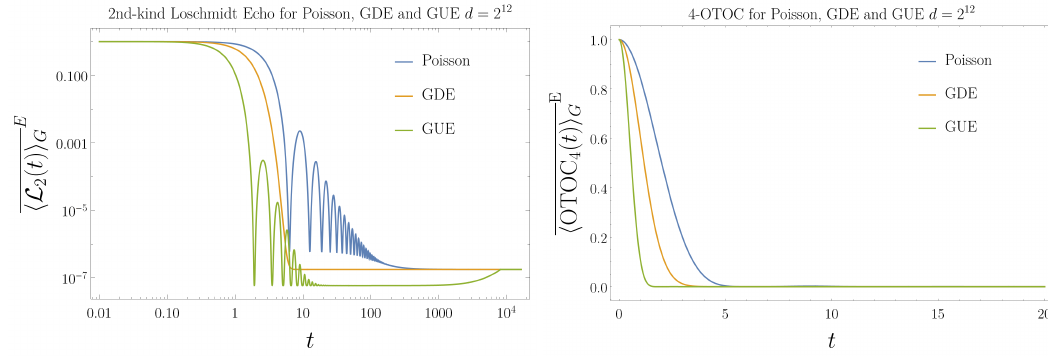
Figure 4: Left : Log-Log plot for the Loschmidt-Echo of the second kind reported in Eq. (36) for Poisson, GDE and GUE ensembles and d = 2 12 . The Loschmidt-Echo for GDE and Poisson reaches the asymptotic value 3 / d 2 after a time O ( O ( d 1 / 2 ) respectively , GUE instead equals the offset 1 / d 2 for the temporal window t ∈ [ O ( d 1 / 3 ) , O ( d )] and then reaches the same asymptotic value. Right : Plot of the 4-OTOC for Poisson, GUE, GDE ensemble for d = 2 12 . The striking feature of the 4-OTOC is the following: while GUE drops to a negative value after a time O ( d 1 / 3 ) , GDE and Poisson never become negative and reach the asymptotic value 1 / d 2 in a (cid:112) time O ( log d ) and O ( d 1 / 2 )